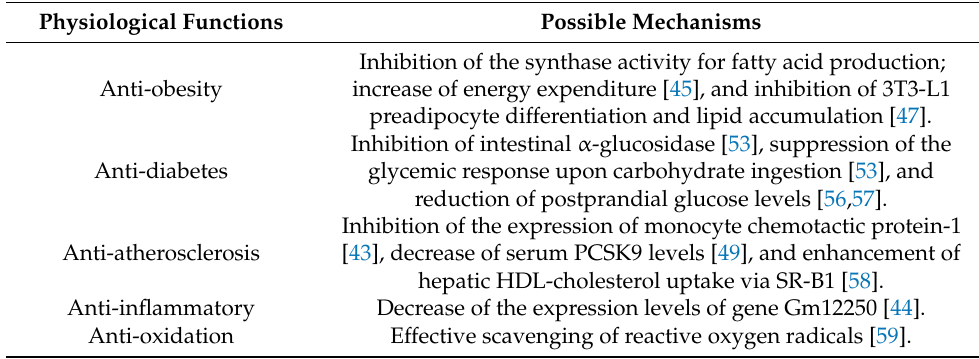
Table 2. The possible mechanisms of D -allulose in various physiological functions. Physiological Functions Possible Mechanisms Inhibition of the synthase activity for fatty acid production; Anti-obesity increase of energy expenditure [45], and inhibition of 3T3-L1 preadipocyte differentiation and lipid accumulation [47]. Inhibition of intestinal α -glucosidase [53], suppression of the Anti-diabetes glycemic response upon carbohydrate ingestion [53], and reduction of postprandial glucose levels [56,57]. Inhibition of the expression of monocyte chemotactic protein-1 Anti-atherosclerosis [43], decrease of serum PCSK9 levels [49], and enhancement of hepatic HDL-cholesterol uptake via SR-B1 [58]. Anti-inflammatory Decrease of the expression levels of gene Gm12250 [44]. Anti-oxidation Effective scavenging of reactive oxygen radicals